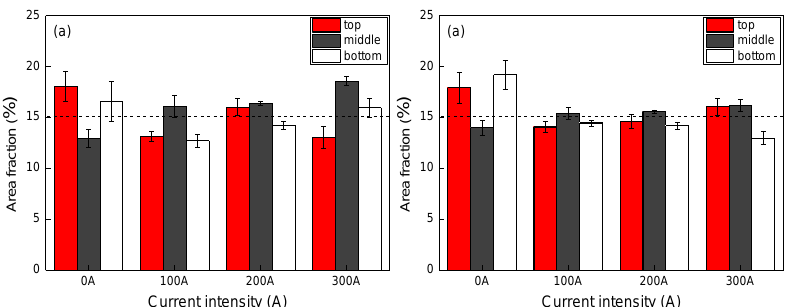
Figure 7. Area fraction of the Co-rich phase in different positions of samples with different stirring current: ( a ) Central part of ingot (on the central-axis); ( b ) Edge part of ingot (3 mm from the edge). The color bars represent different height (top: 25 mm, middle: 15 mm, bottom: 5 mm) from the ingot base.